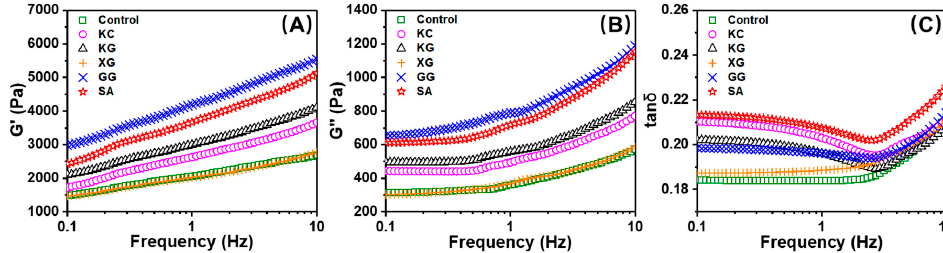
Figure 3. Effect of different polysaccharides on the dynamic rheological characteristics of unwashed surimi gel. ( A ) Storage modulus (G’); ( B ) loss modulus (G”); ( C ) loss tangent (tan δ ). KC: κ -carragee- washed surimi gel. ( A ) Storage modulus (G (cid:48) ); ( B ) loss modulus (G (cid:48)(cid:48) ); ( C ) loss tangent (tan δ ). KC: nan; KG: konjac gum; XG: xanthan gum; GG: guar gum; SA: sodium alginate. κ -carrageenan; KG: konjac gum; XG: xanthan gum; GG: guar gum; SA: sodium